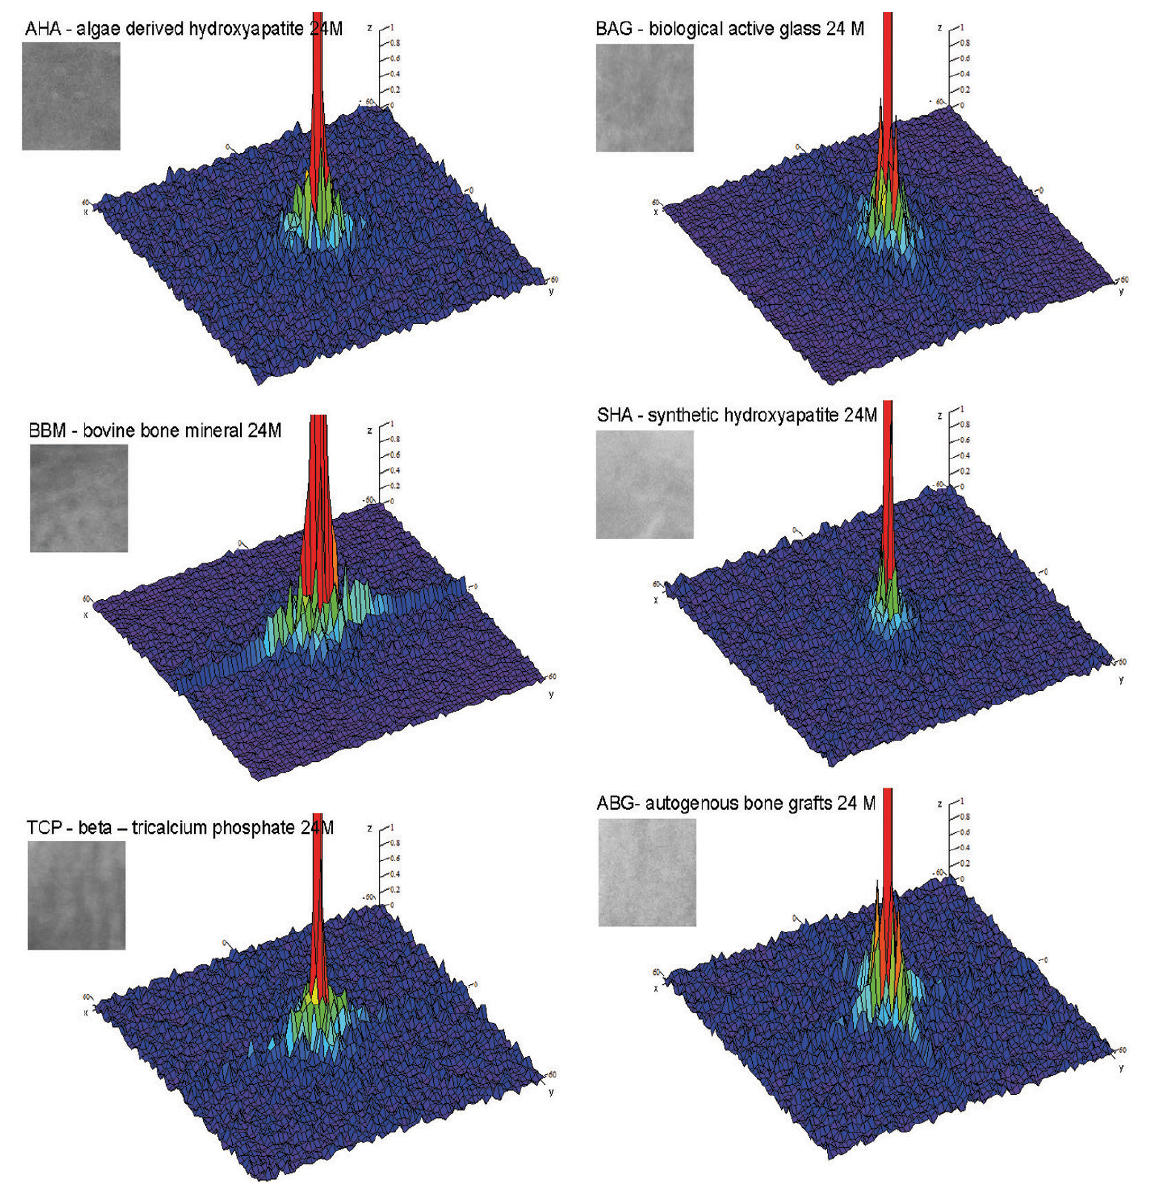
Figure 1c. Results of Fourier Transformation: 3 dimension presentation of amplitude distributions the Fourier Transformation of analysed images; (axes: x,y – spatial frequencies, z – amplitude). Abbreviation: 24M – twenty four months after